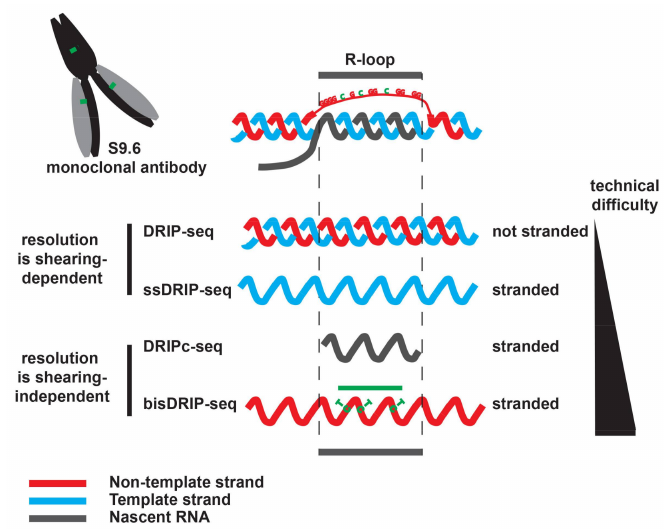
Figure 1. Genome-wide mapping of DNA:RNA hybrids using DNA:RNA immunoprecipitation (DRIP)-like